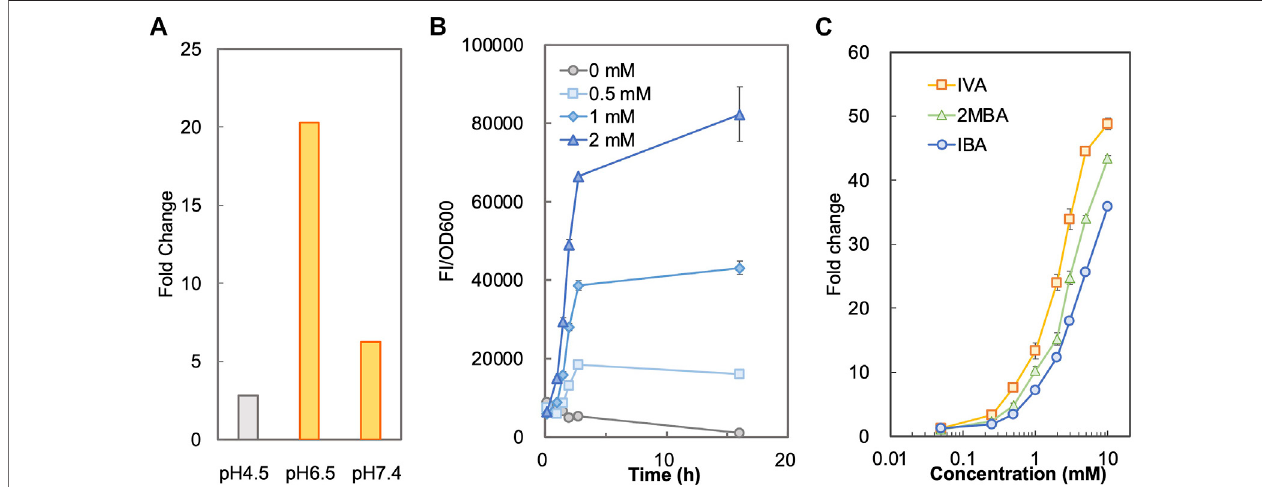
FIGURE 1 | Characterization of biosensor BY4741-S LCA . (A) Responses of BY4741-S LCA cells (fold changes) to IBA under different pH conditions. BY4741-S LCA cells were grown in SCD-U medium under buffered (at pH6.5 and pH7.4) or unbuffered (at pH4.5) pH conditions. GFP fl uorescence wasmeasured after incubation with 1.0 mM IBA and normalized to cell density (OD600). The fl uorescence of control without the IBA supply was normalized to its cell density and set to 1. (B) Time-course fl uorescence intensityofBY4741-S LCA cellsinresponsetoIBAsuppliedintothemedium.BY4741-S LCA cellswereincubated inthebuffered SCDmedium (pH6.5) withIBAsupply(at0.5,1,and2 mM).The fl uorescencewasmeasured andnormalized tocelldensity (OD600). (C) Dose-dependentresponsesofBY4741-S LCA cellsto respectiveSBCFA,i.e.IVA,2MBAandIBAaftera3-hincubation.FI, fl uorescenceintensity.Valuesaremeansofthreeindependentexperiments.Anerrorbarrepresents a standard deviation of three independent